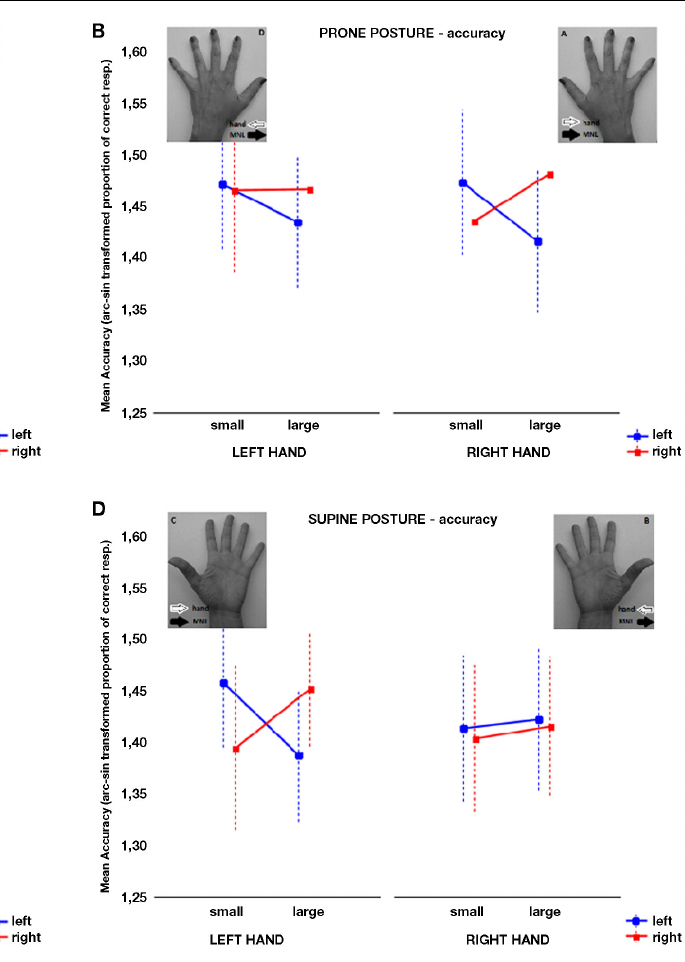
likely driven by the difference between left and right key for large numbers). (C,D) When participants kept their hands in a supine posture, the SNARC effect was significant for the left hand only (and likely driven by the difference between left and right key for small numbers).